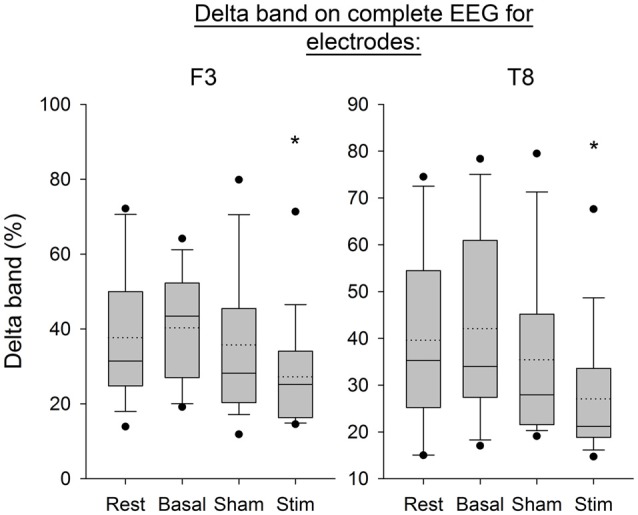
EEG Delta band on complete signal for the electrodes F3 and T8 for all subjects per condition. The boxes correspond to the 25–75 percentiles, the continuous lines are the median values, the dotted lines are the mean values and the whiskers represent the 10 and 90 percentiles. The dots are the outlying values. Note the decrease for the active stimulation condition. The Delta band is expressed in percent (%), *p < 0.05 as compared to the three other conditions.